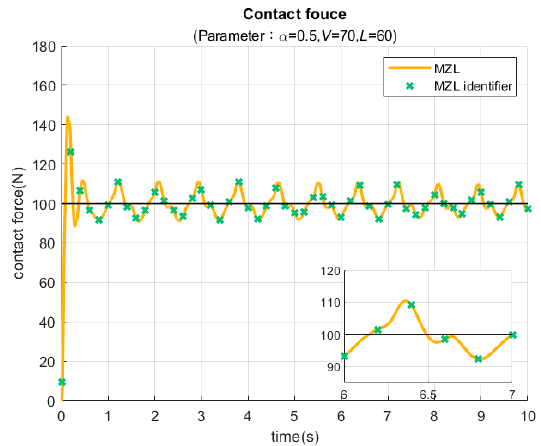
Figure 4. The IT2AFNNI simulation performance. Step (2) The membership functions µ e and µ de for IT2AFLC are selected as shown in Figure 5.